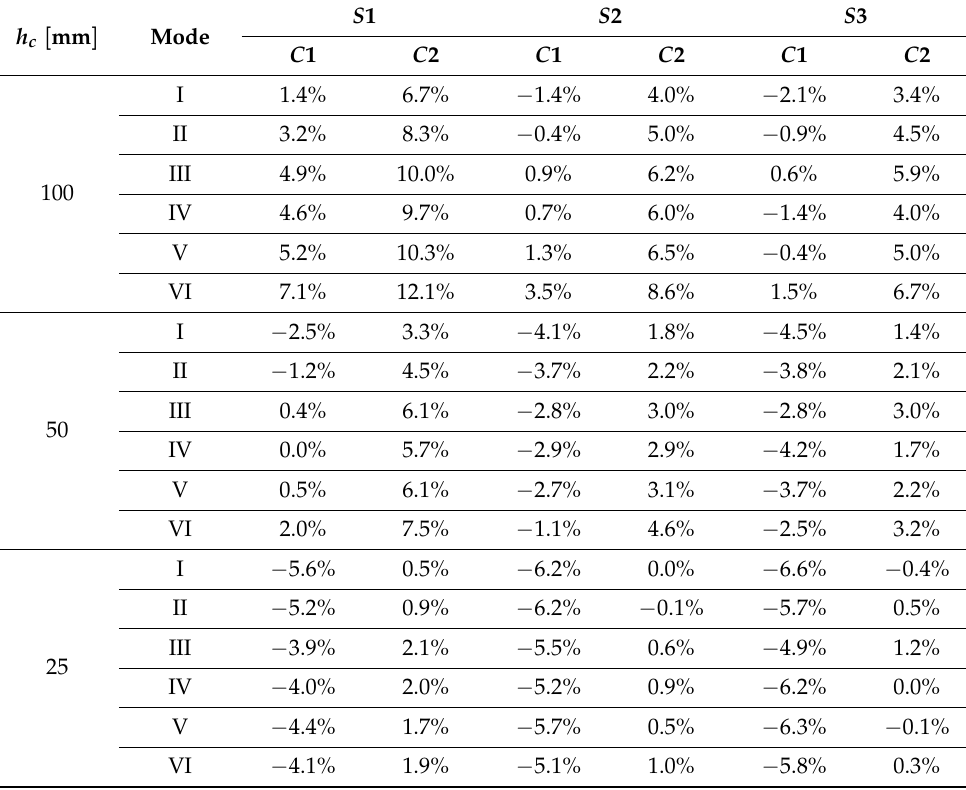
Table 3. The relative errors between averaged models and FEM model for a = 0.015 m.